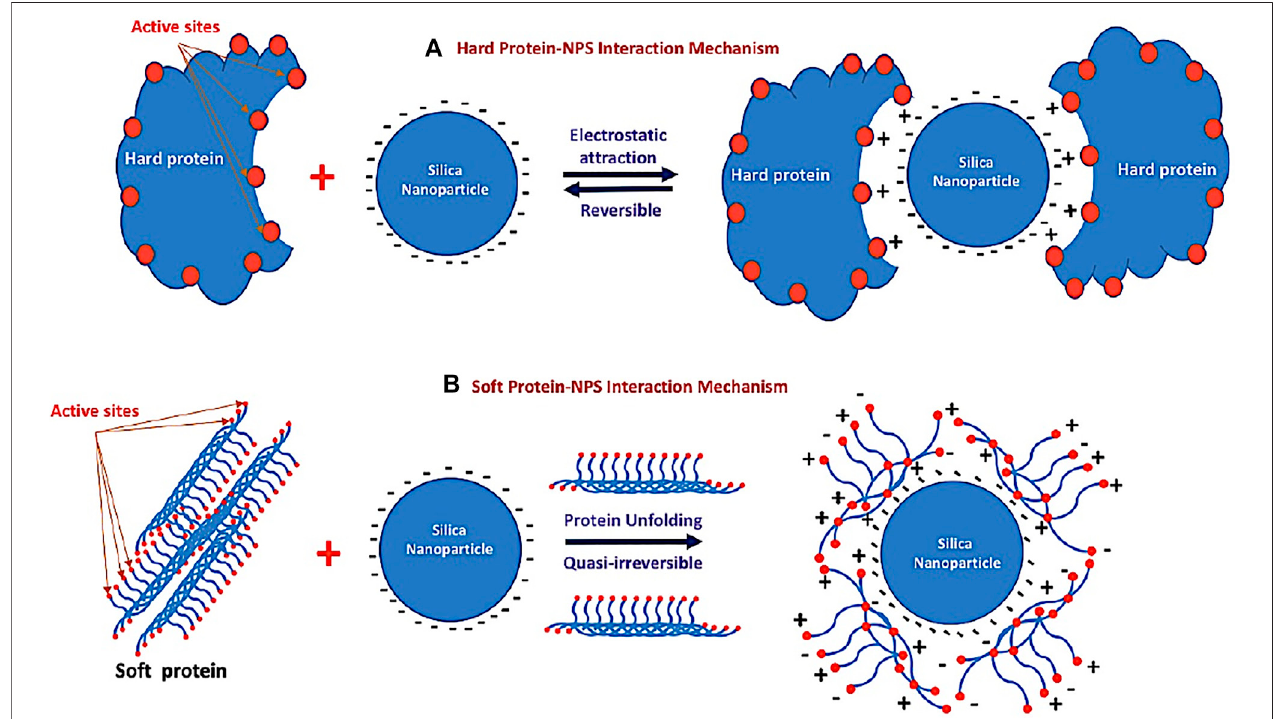
FIGURE 8 | Schematic diagram of the different mechanisms of the interaction between silica nanoparticles and different types of proteins. (A) Reversible electrostatic mechanism between silica nanoparticles and hard protein and (B) quasi-irreversible mechanism between silica nanoparticles and the soft protein after